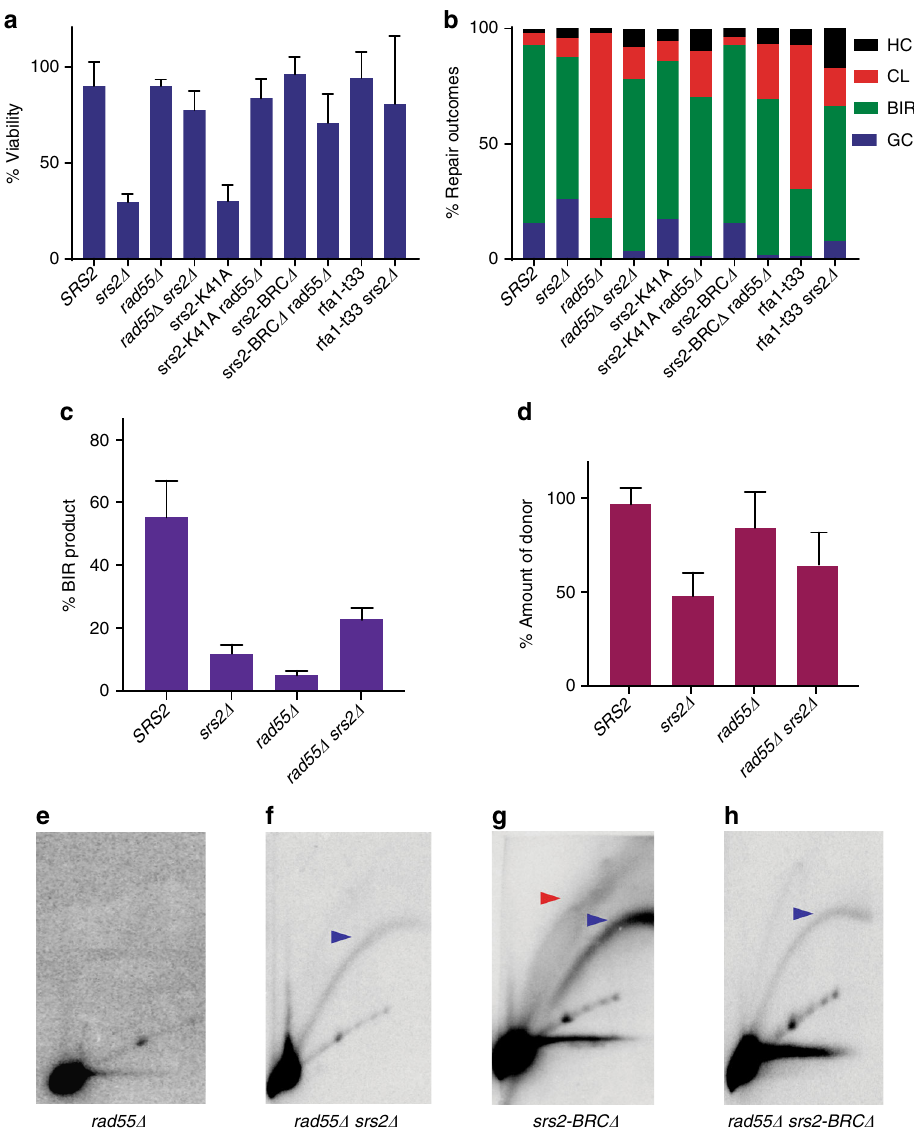
Fig. 4 Destabilization of Rad51 fi lament bypasses the requirement for Srs2 during BIR. a Cell viability following DSB induction in rad55 Δ , rfa1-t33 and srs2 Δ mutants. b distribution of repair outcomes following DSB induction in rad55 Δ , rfa1-t33 and srs2 Δ mutants. Quanti fi cation of BIR product c and of the donor entering the gel d measured at 8 h following DSB repair initiation. e - h 2D gel analysis of BIR intermediates in the following rad55 and srs2 mutants: e rad55 Δ , f rad55 Δ srs2 Δ , g srs2-BRC Δ , and h rad55 Δ srs2-BRC Δ . Blue and red arrowheads denote bubble arc intermediate and “ rubble ” structure respectively. Quanti fi cation of cell viability, amount of BIR product, and amount of donor was based on ≥ 3 independent experiments and are presented as means with standard deviations